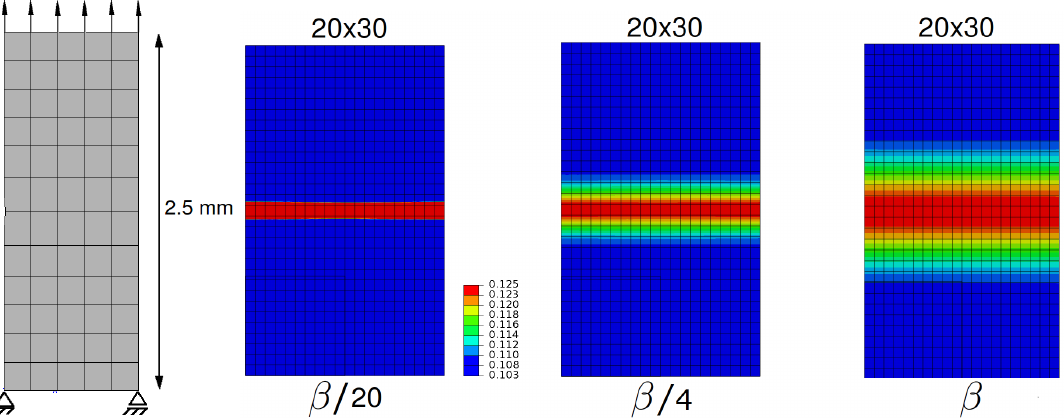
Figure 4. Regularized damage bands in varying sizes manipulated by the parameter β (contour maps of d ).